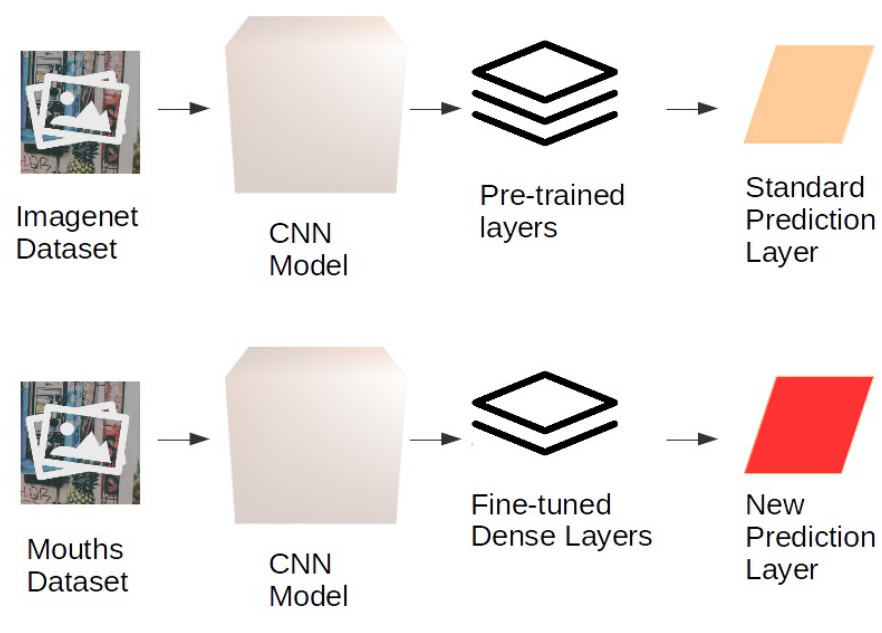
Figure 2. General scheme of the adapted transfer learning techniques with the considered CNNs.